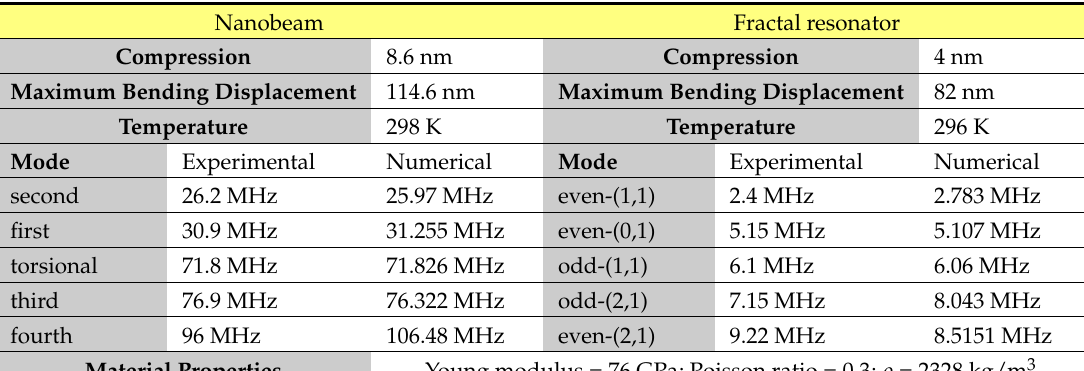
Figure 8. The first five resonant modes of vibration and their corresponding frequencies for the compressed fractal structure. Red colour denotes maximum displacements while + and − signs denote the positive and negative amplitudes along z-axis (orthogonal to the xy-plane). In Tables 1 and 2 the frequencies at which the modes appear for the uncompressed and compressed structures are shown. Table 2. Table of the first five resonant modes together with their frequencies for compressed beam, Columns 2 and 3, and the compressed fractal structure, Columns 5 and 6. The last row shows the fitted material properties of the suspended